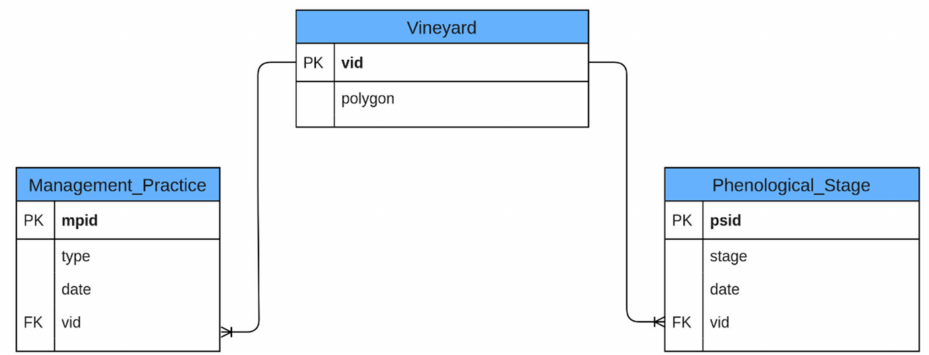
Figure 3. Relational schema of the database.